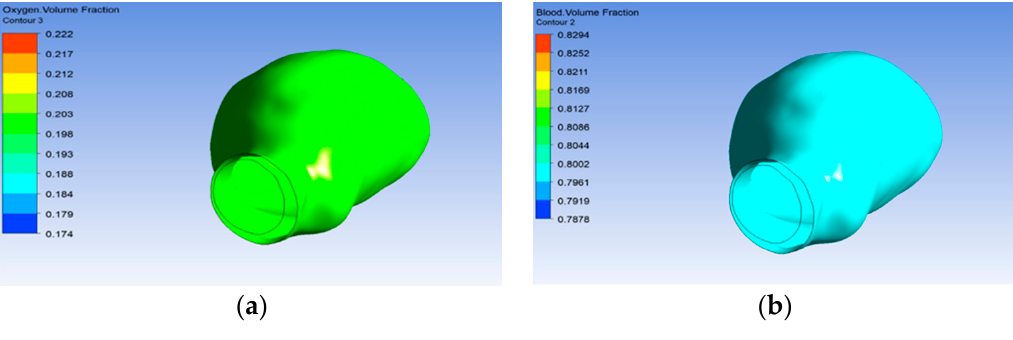
Figure 11. Volume of ( a ) oxygen and ( b ) blood.